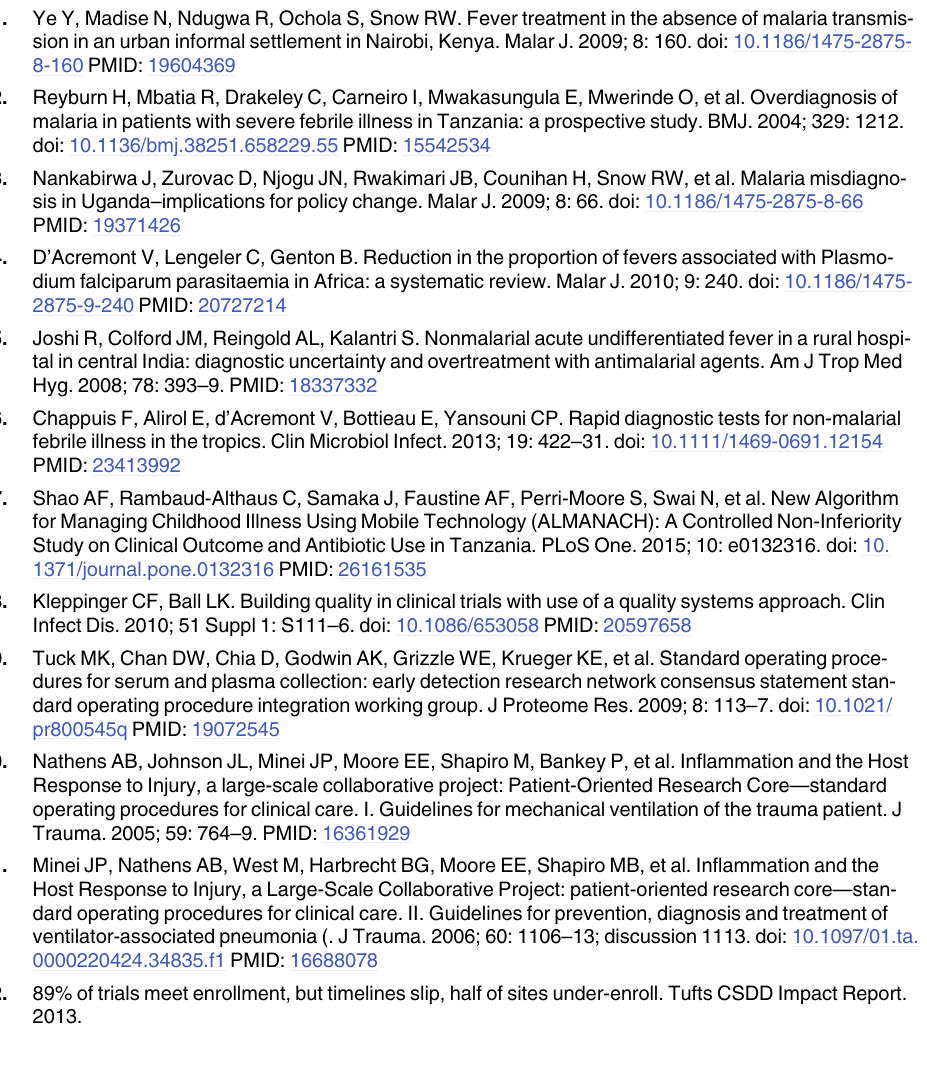
S1 Table. Overviewof the standard operating procedures (SOPs) used in the NIDIAG febrile syndrome